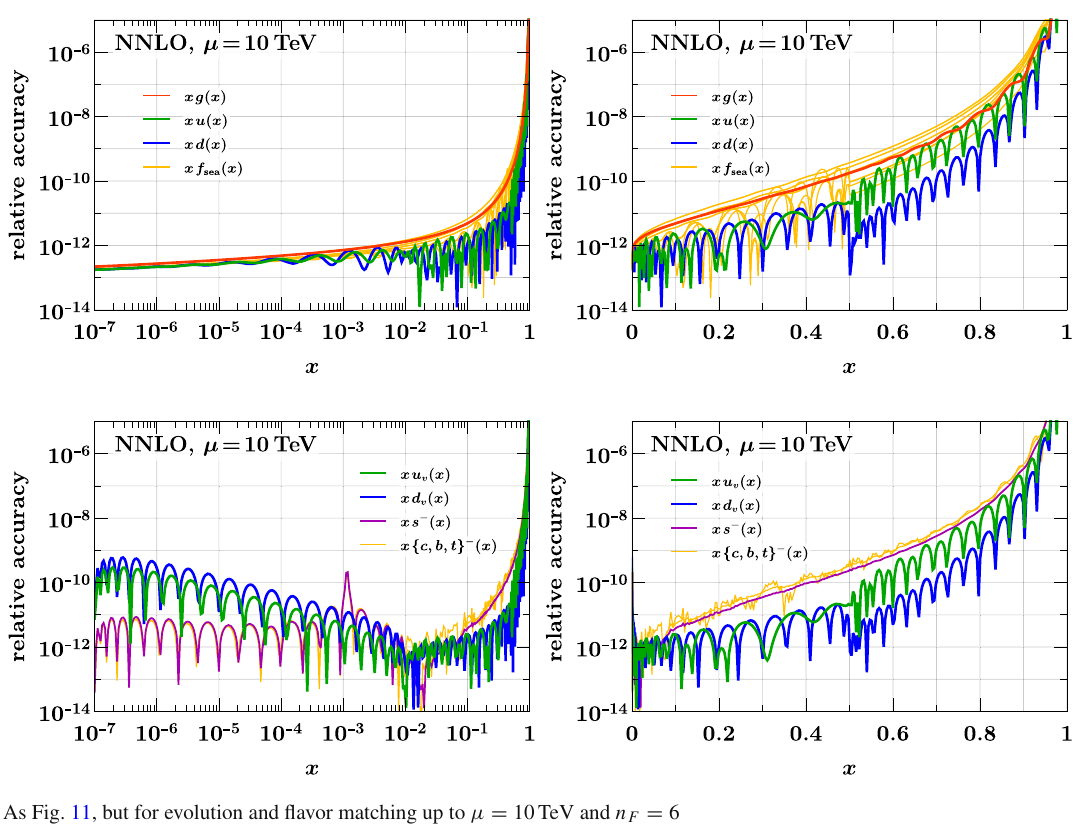
Fig. 12 As Fig. 11, but for evolution and flavor matching up to μ = 10TeV and n F = 6